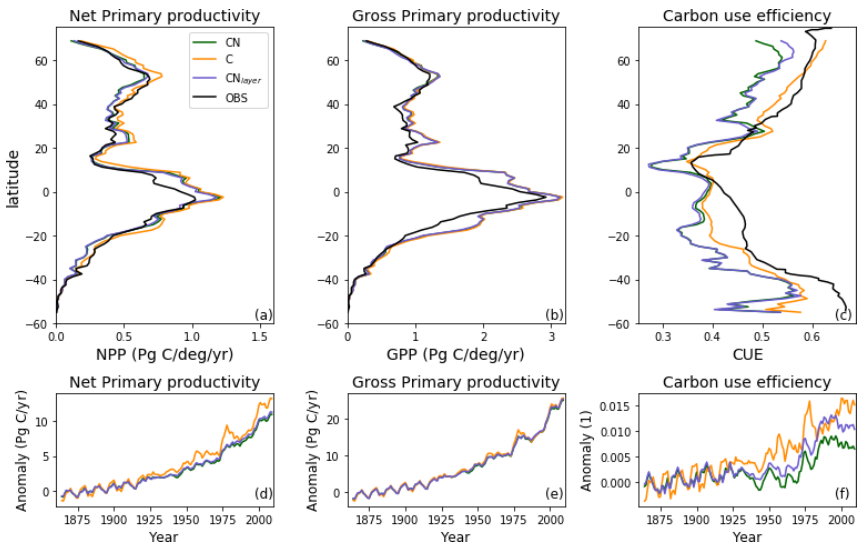
Figure 5. Zonal total values of (a) net primary productivity (NPP) and (b) gross primary productivity (GPP) for JULES-C, JULES-CN, and JULES-CN layer simulations for the period 1996–2005 inPgC(degree latitude) − 1 yr − 1 . The observational constraint for NPP is from MODIS (Zhao and Running, 2010) and that for GPP is from Jung et al. (2011). The zonal mean carbon use efficiency (CUE = NPP / GPP) is shown in (c) . The CUE observational constraint was digitised from Kim et al. (2018). Also shown are changes in (d) NPP, (e) GPP, and (f) CUE over the historical period with respect to the multi-annual mean period of